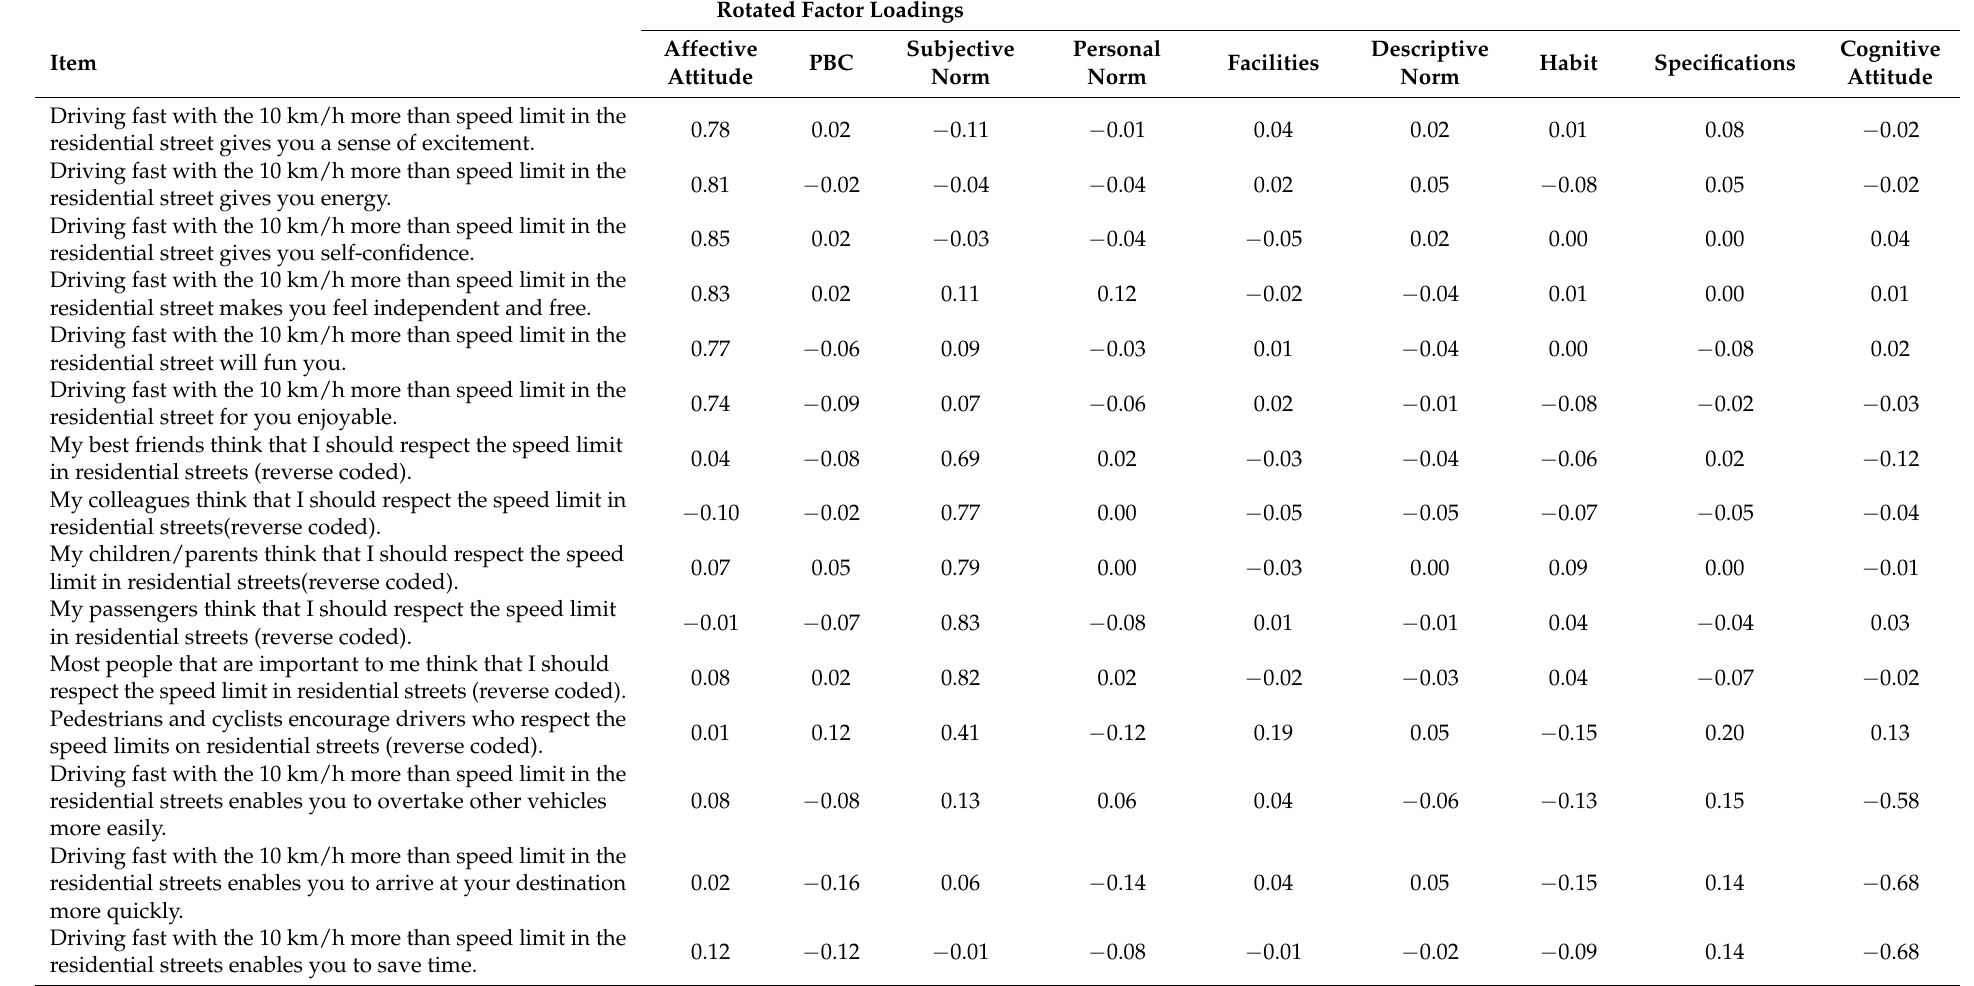
Table 2. Results of factor analysis with Direct Oblimin rotation (N =